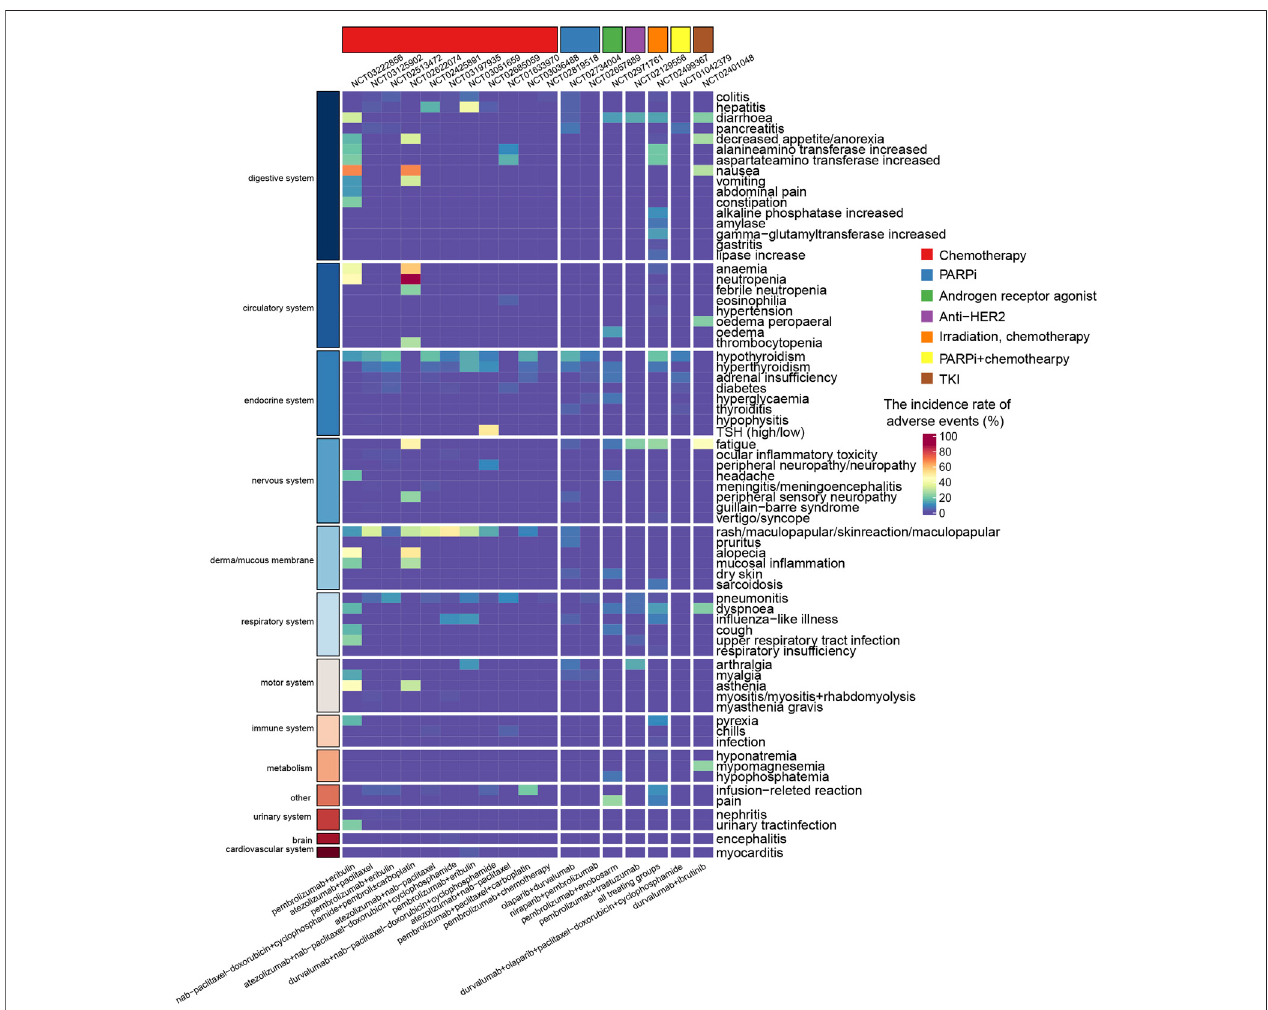
FIGURE 4 | Heatmap showing the incidence rate of immune-related adverse events induced by combination therapy with PD-1/PD-L1 blockade. The color gradient shows the incidence rate of adverse events, where red and blue colors indicate a high and low rate. The regimen of nab-paclitaxel- doxorubicin+cyclophosphamide was nab-paclitaxel followed by doxorubicin and cyclophosphamide.